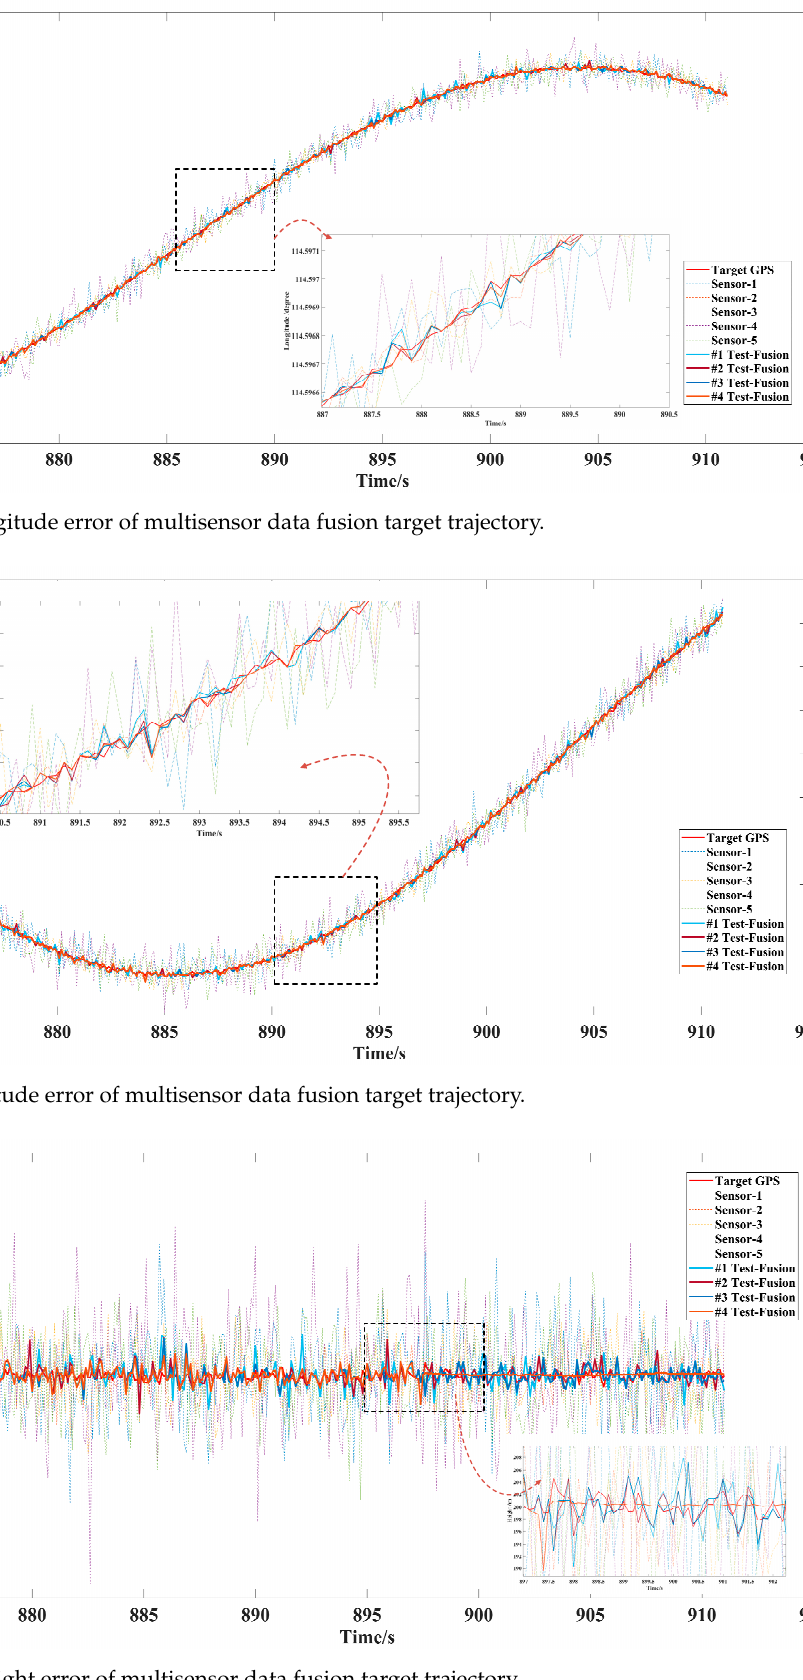
Figure 10. Height error of multisensor data fusion target trajectory.